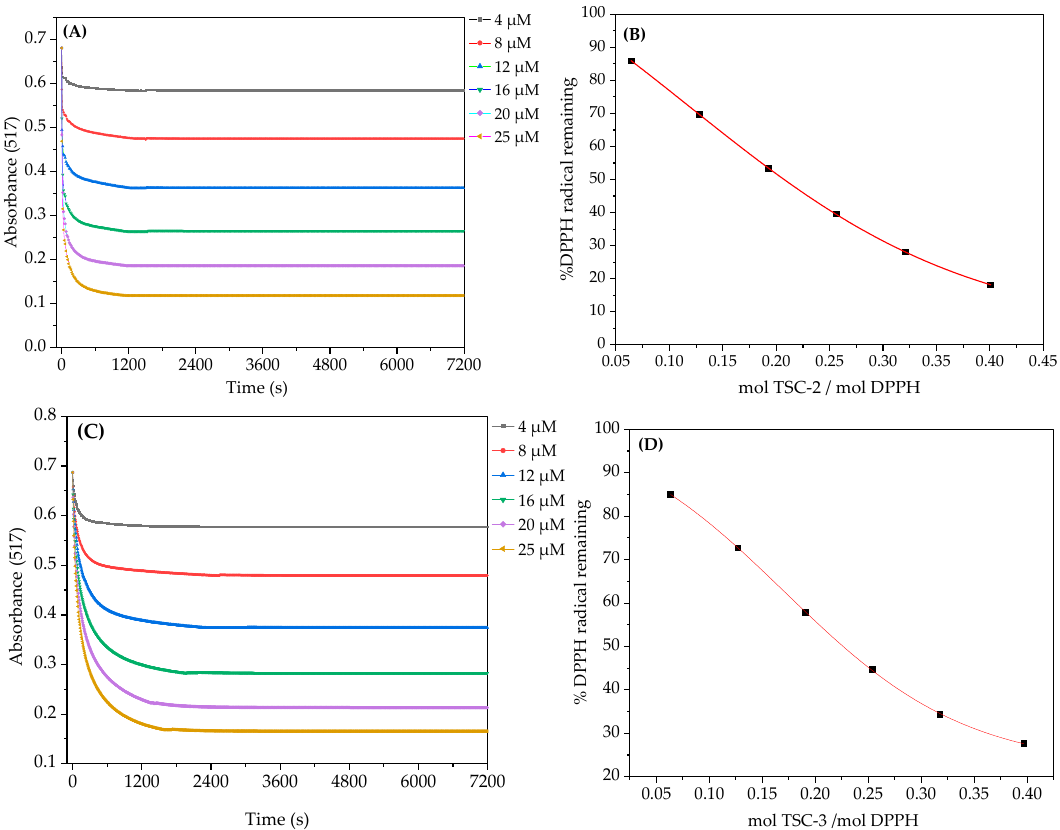
Figure 3. Reaction kinetics of DPPH radical with TSC-2 ( A ) and TSC-3 ( C ); %DPPH radical remaining at infinite time at the different concentration of TSC-2 ( B )and TSC-3 ( D ) . By analyzing the data as described in the experimental portion, the EC 50 (mol AH/mol DPPH), stoichiometric factor( n ) and the bimolecular rate constants(k b ) were procured (Table 1), which are